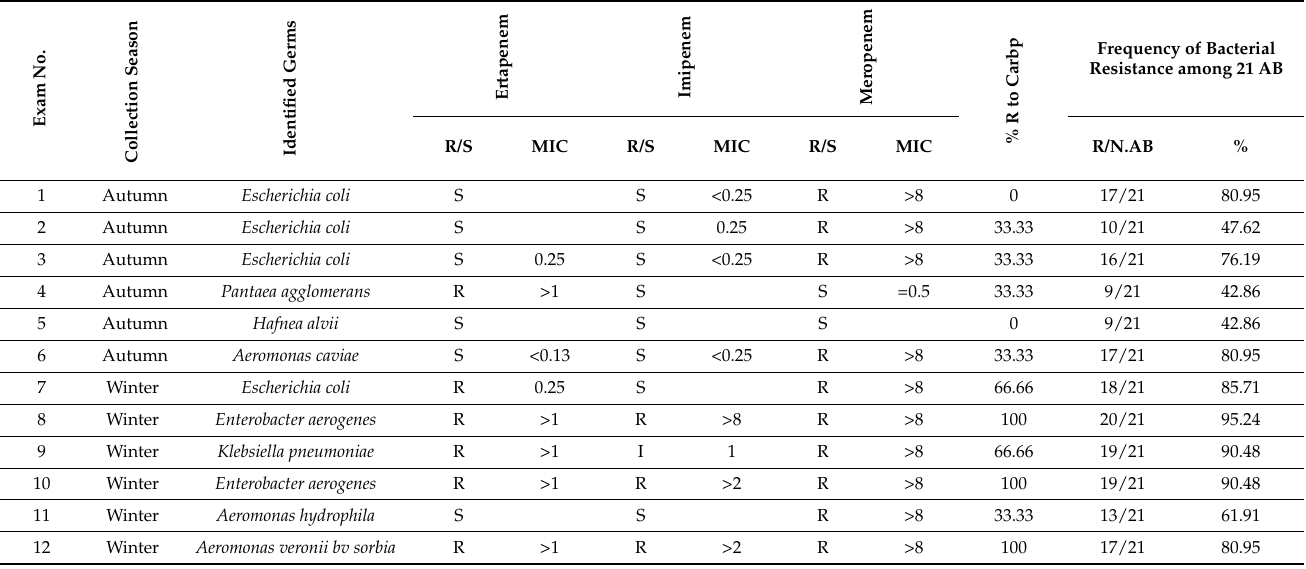
Table 1. The strains isolated and identified in Ar-razi Hospital effluent with their antibiotic suscepti- bility tests